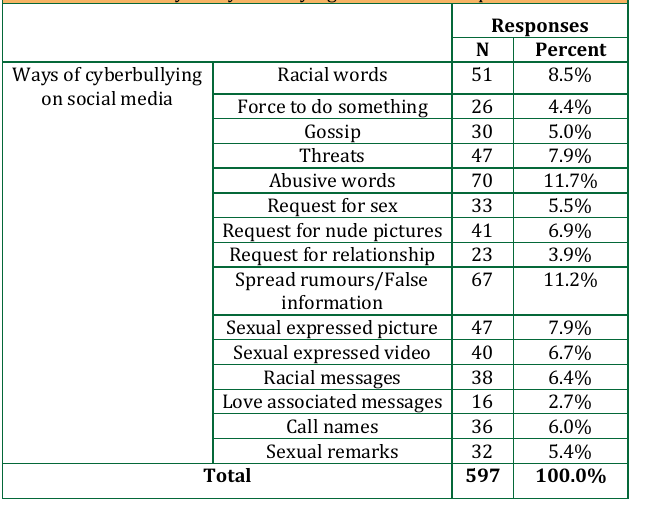
Table 5: Ways of cyberbullying on social media platforms